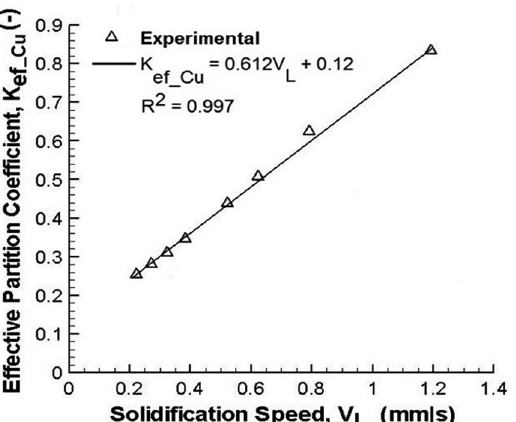
) versus solidification ef_Cu